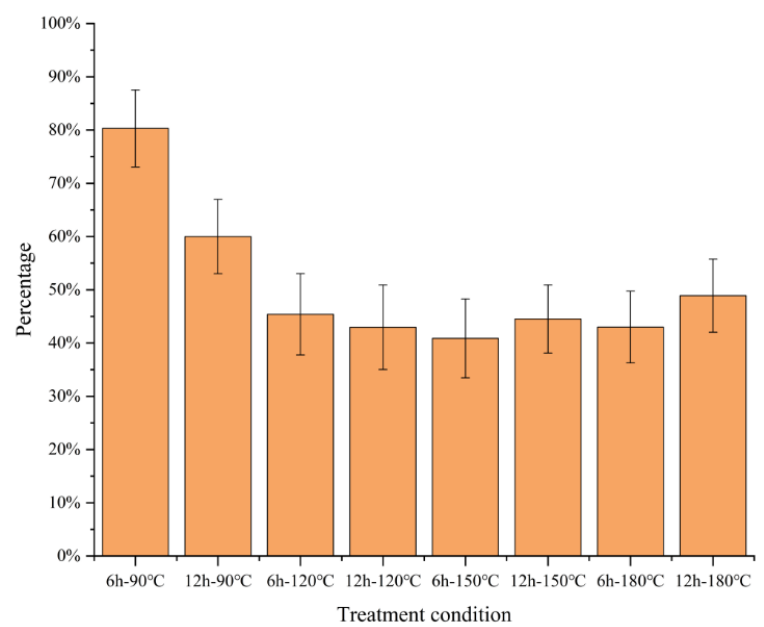
Figure 2. Recovered wheat straw solid residues obtained from various DES pretreatment conditions.